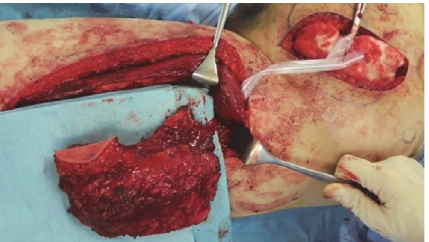
Figure 1: A pedicled vastus lateralis-anterolateral thigh flap was elevated from the left thigh. The flap was harvested together with a motor nerve.